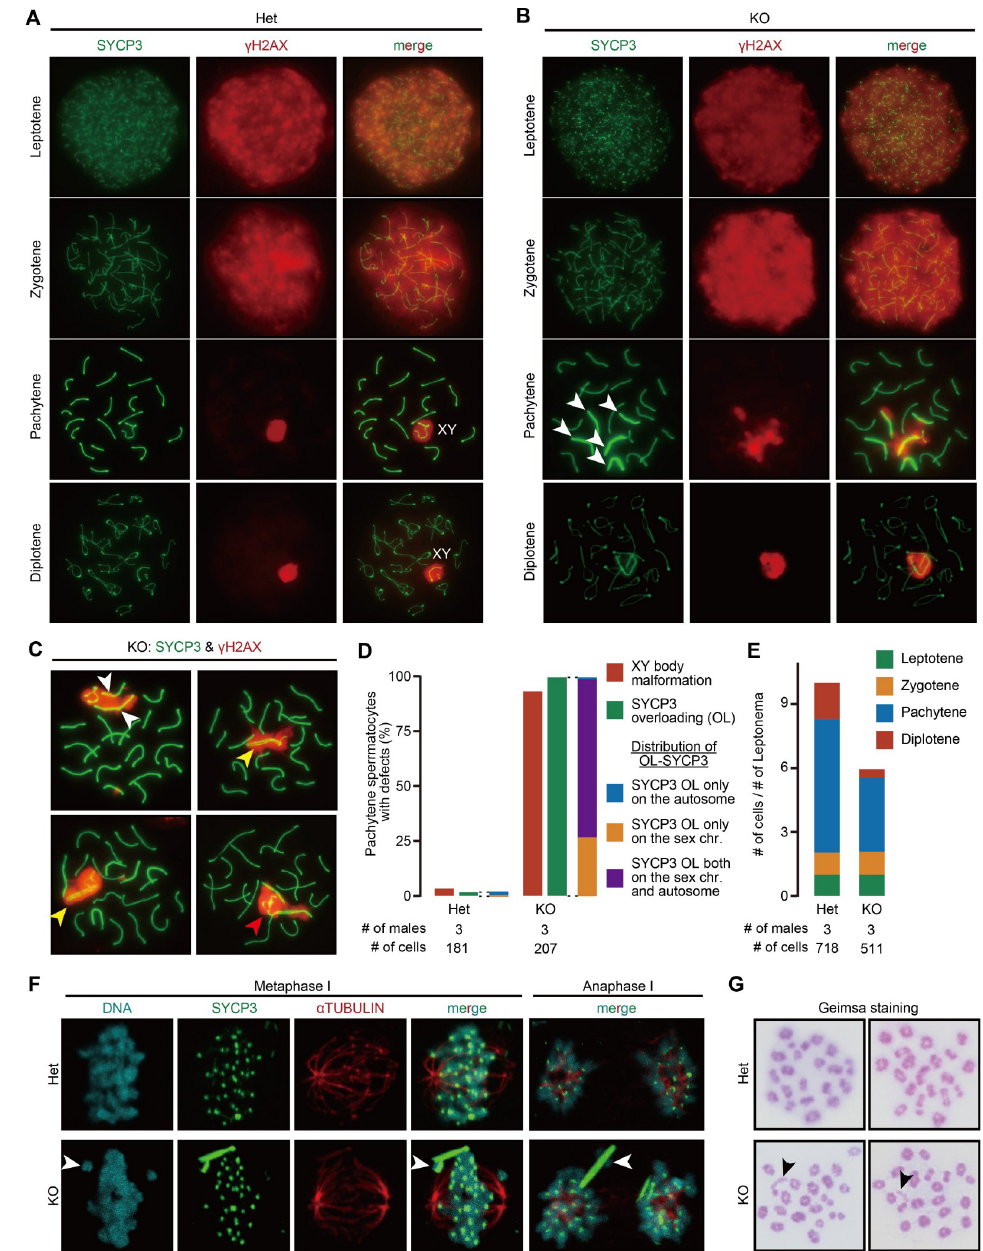
Fig 3. Cytological analysis of Trim41 KO spermatocytes. (A and B) The spread nuclei of prophase spermatocytes collected from adult Het (A) and KO (B) male mice were immunostained with anti-SYCP3 and - γ H2AX antibodies. XYs in (A) indicate the sex chromosomes encircled by γ H2AX signals (i.e. XY body). White arrowheads in (B) indicate intense SYCP3 signals. At least three male mice were analyzed. (C) Additional immunostaining images of KO spermatocytes. The white arrowheads indicate the separate SYCP3 signals in autosomes. The yellow arrowhead indicates the X chromosome with two SYCP3 axes. The red arrowhead shows a tangled SYCP3 signal between the sex chromosome and autosomes (only 17 axes existed other than the tangled SYCP3 signals). (D) The percentage of pachytene stage spermatocytes exhibiting XY body malformation (red bar graph) and SYCP3 overloading (green bar graph). Blue, purple, and yellow-colored boxes show the distribution of chromosomes (i.e., sex chromosome or autosome) exhibiting SYCP3 overloading. The numerical data are available in S3 Table (E) The percentage of each meiotic prophase stage in immunostained spread nuclei samples in A and B. The numerical data is available in S3 Table (F) Immunostaining of metaphase and anaphase spermatocytes squashed from seminiferous tubules after fixation. Blue arrowheads indicate chromosomes connected with the rod-like SYCP3 structures. At least three male mice